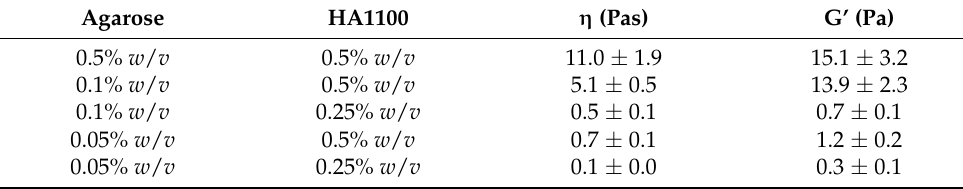
Table 5. Composition and rheological characteristics of synthetic vitreous